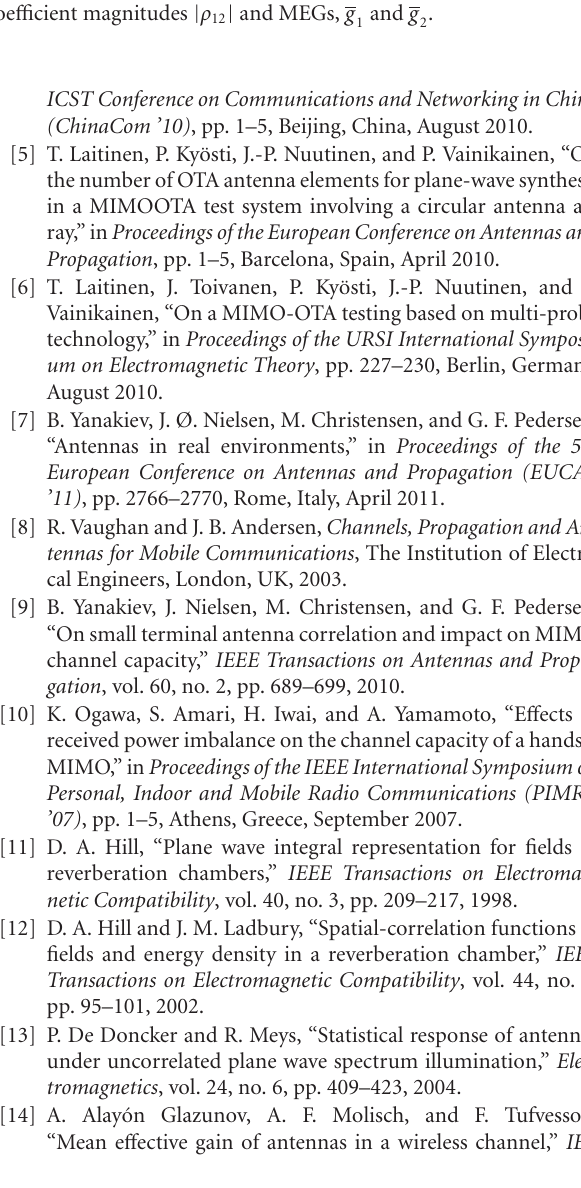
Figure 6: Median capacity for ranges of correlation coe ffi cient magnitudes | ρ 12 | and MEGs, g